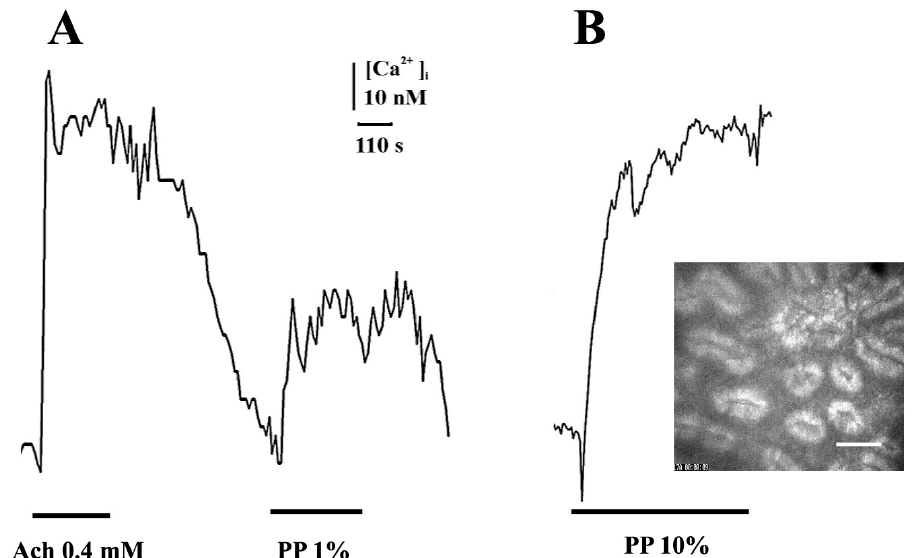
Figure 2. Calcium dynamics in rat colon segment in response to application of various concentrations of PP and acetylcholine (Ach). The duration and concentrations of PP and Ach are shown by horizontal lines under the registration of calcium curves. ( A ) Ach (0.4 mM and 1% PP). ( B ) 10% PP. Vertical mark—concentration of intracellular calcium (nM); horizontal—time (s). The colon segment is shown in the insert, the fluorescence is at 340 nM plus visible light and the mark is 50 μ m.